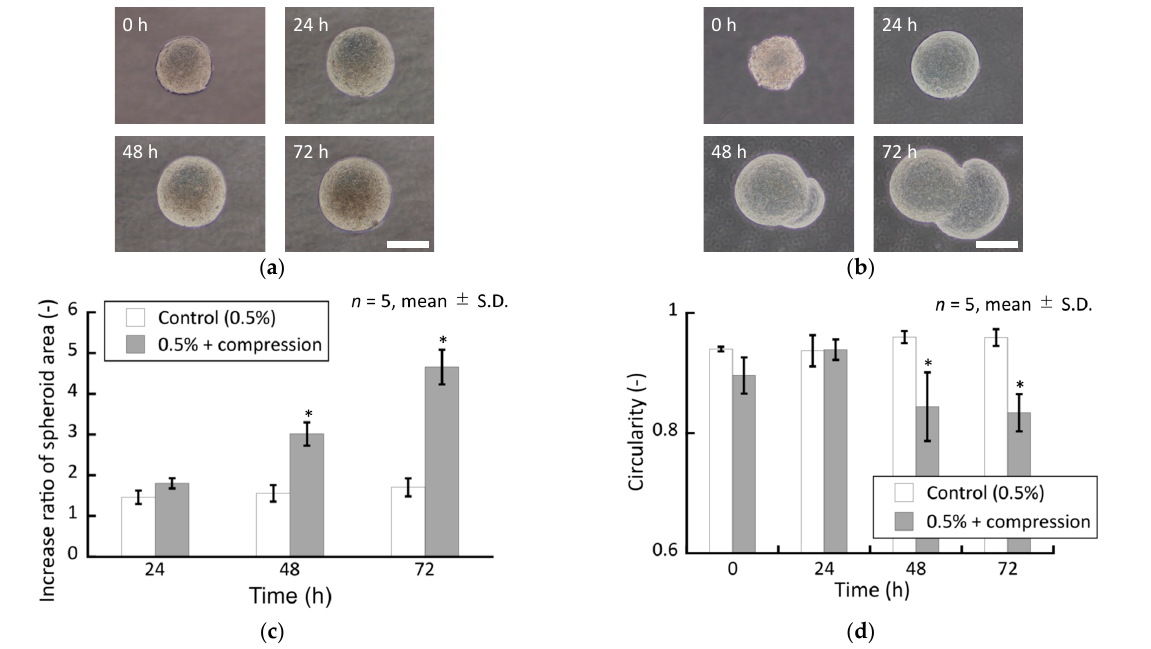
Figure 10. Phase-contrast images of the DLD-1 cell spheroids cultured in the 0.5% agarose gel ( a ) without and ( b ) with external compressive loading. Scale bar: 200 µm. Quantitative characterization of the cultured spheroids. ( c ) Increase ratio of spheroid area and ( d ) circularity of spheroids. * indicates a significant difference compared to control groups ( p < 0.05).